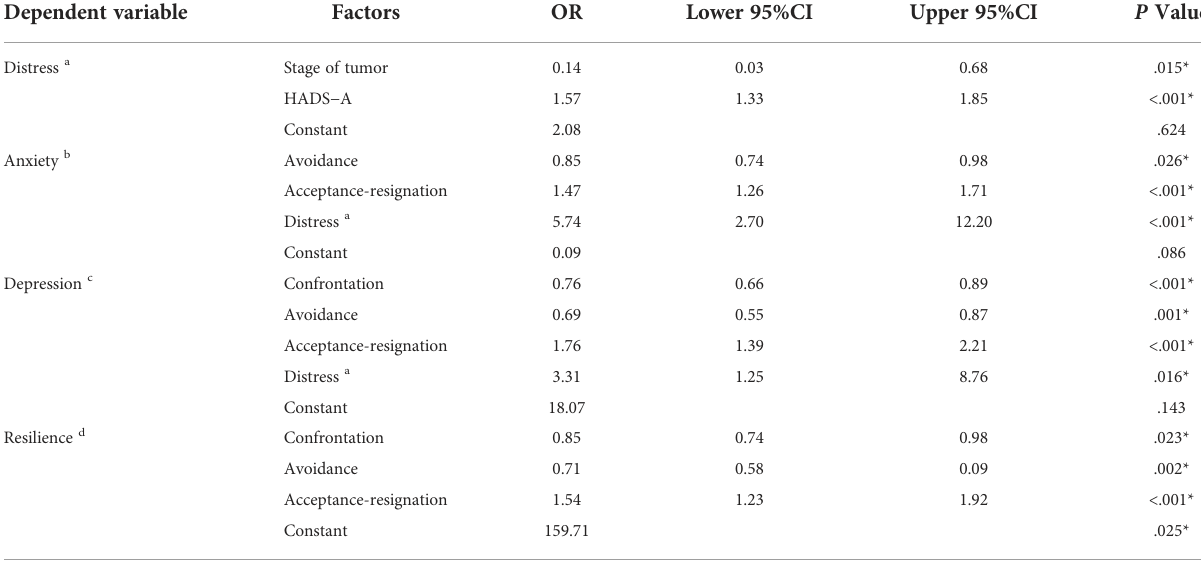
TABLE 3 Logistic regression analysis of factors in fl uencing the level of psychological distress and resilience. Dependent